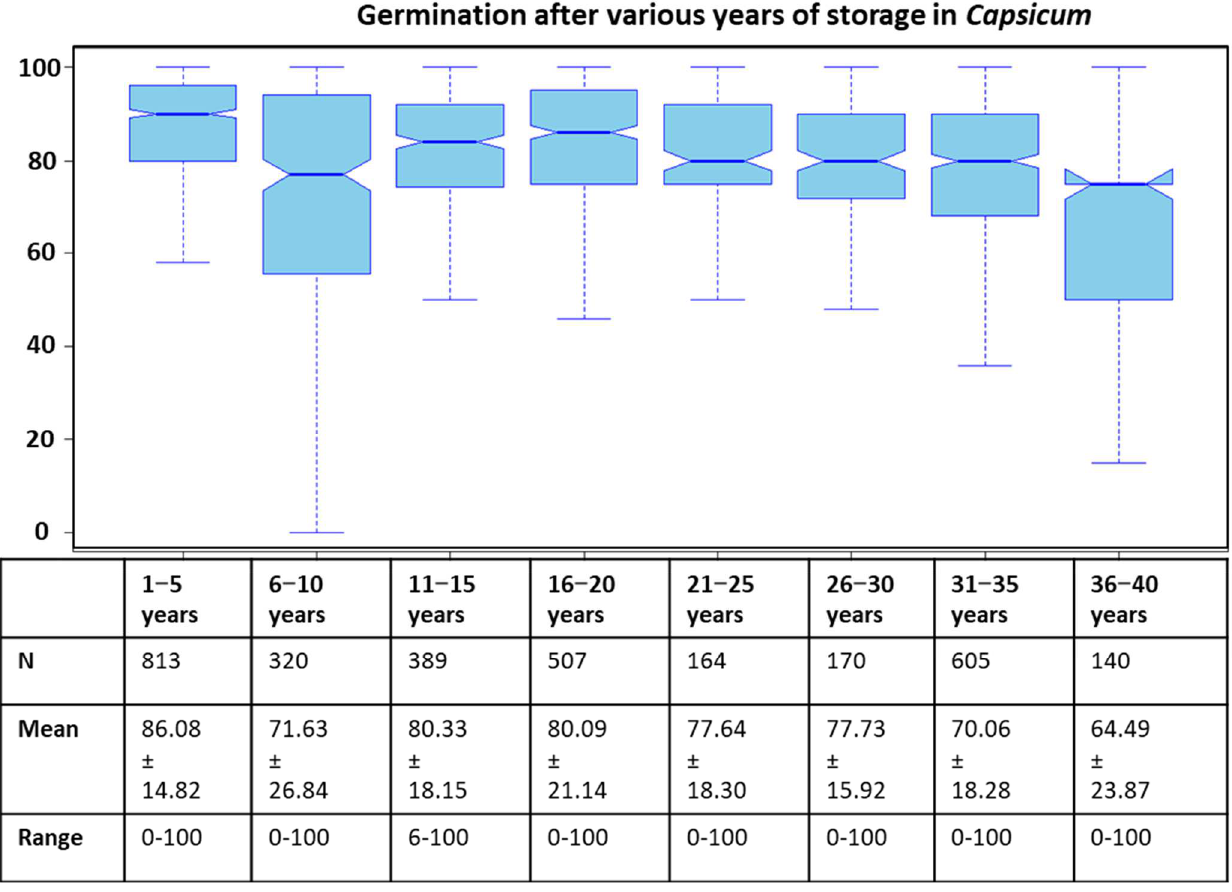
Figure 1. Mean (± standard deviation) germination percentages (seed survival) after various years of storage in Capsicum, where N = sample size.